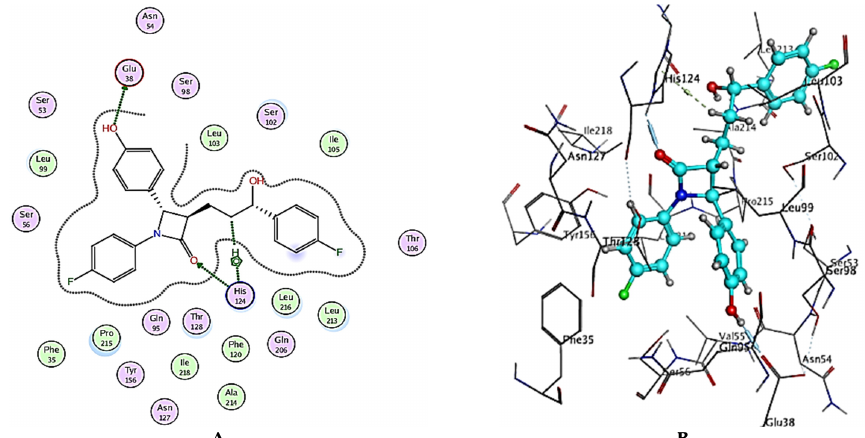
Figure 6. ( A ) Two-dimensional interactions and ( B ) three-dimensional interactions of Ezetimibe fitted into the binding site of NPC1L1 (pdb code: 3QNT) illustrating interactions with amino acid residues in the binding site.